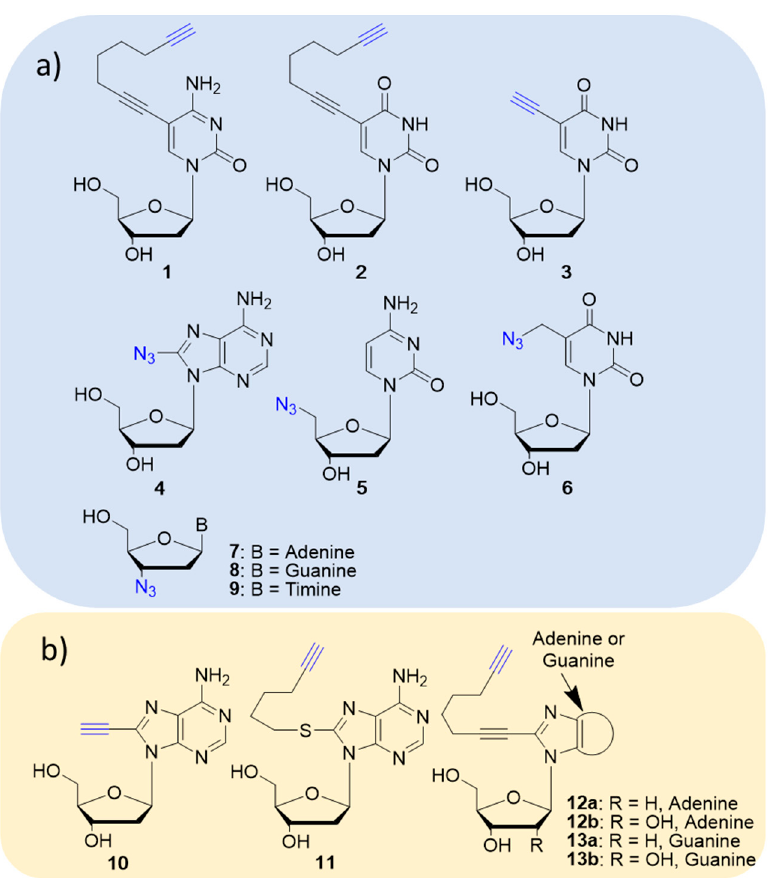
Figure 2. Molecular structure of nucleosides functionalized with alkyne- or azide-reactive handles: ( a ) commercially available; ( b ) reported in Reference [29].